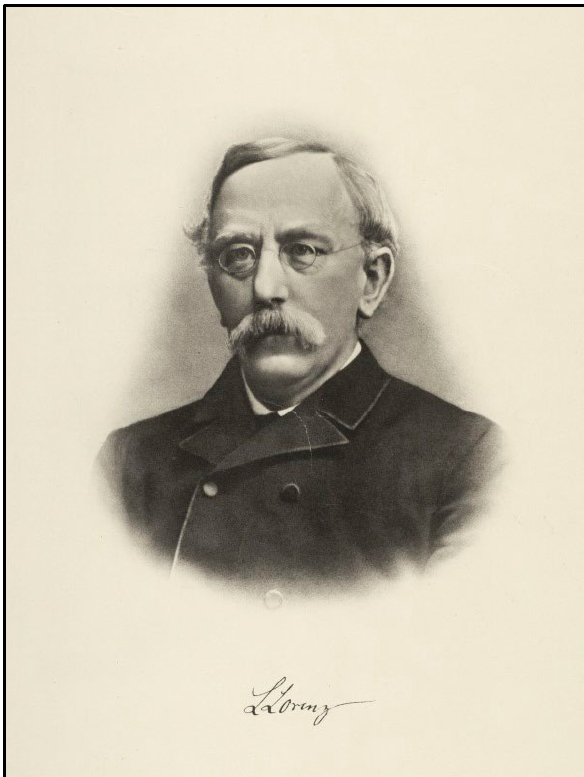
Figure 5. Ludvig V. Lorenz. Royal Library, Copenhagen, Picture